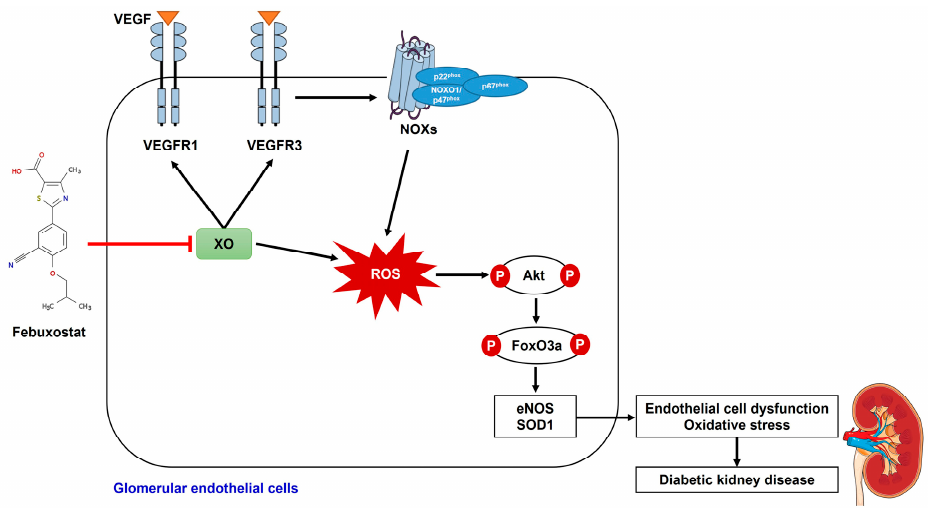
Figure 9. The schematic illustration of the proposed molecular mechanism for renoprotective effects of XO inhibition in DKD.